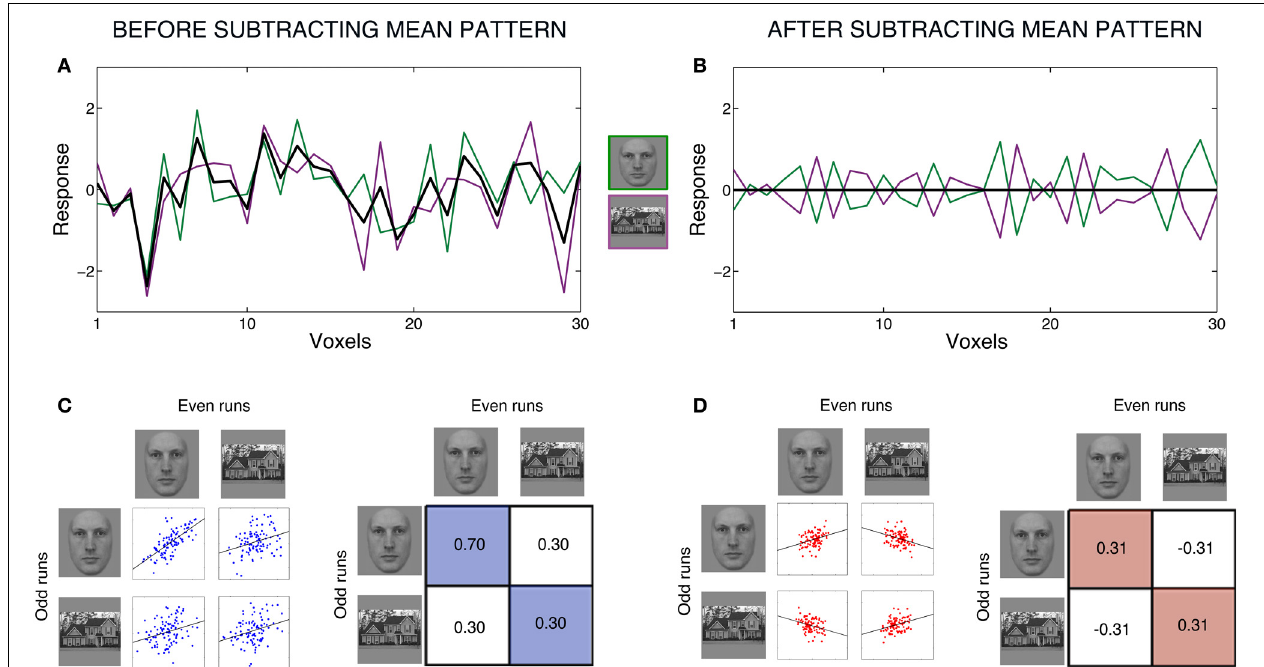
FIGURE 1 | Effects of subtracting the mean pattern for a case with two conditions. Figure shows an example with simulated patterns of responses to two conditions, faces and houses. We simulated the responses for two datasets, which would correspond to average responses to each condition in even runs and average responses in odd runs. Responses were generated for 100 voxels. All correlations among conditions were set to be ∼ r = 0 . 3 to simulate the effects of a common activation pattern. In addition, the correlation for the condition faces between even and odd runs was set to be ∼ r = 0 . 7, to simulate moderately reliable response to this condition across datasets. We carried out many simulations but only retained the one in which the correlations were within 0.005 of the intended values. All data is for one single simulation (one “subject”). Left panels (A,C) show raw data (before subtracting the mean pattern) and right panels (B,D) show data after subtracting the mean pattern. Panels (A,B) show response patterns within half of the data (for example, even runs) for 30 voxels. Panel (A) shows the responses to each condition, with voxels on the x-axis and response magnitude on the y-axis. Faces are in green, houses are in purple, and the black line shows the mean of both